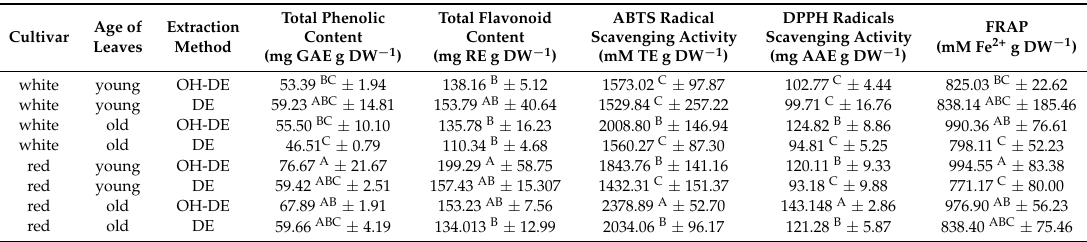
Table 4. Total phenolic content, total flavonoid content, ABTS radical scavenging activity, DPPH radical scavenging activity and ferric reducing antioxidant power (FRAP) values of yacon leaves which were extracted with ohmic-assisted decoction (OH-DE) and decoction